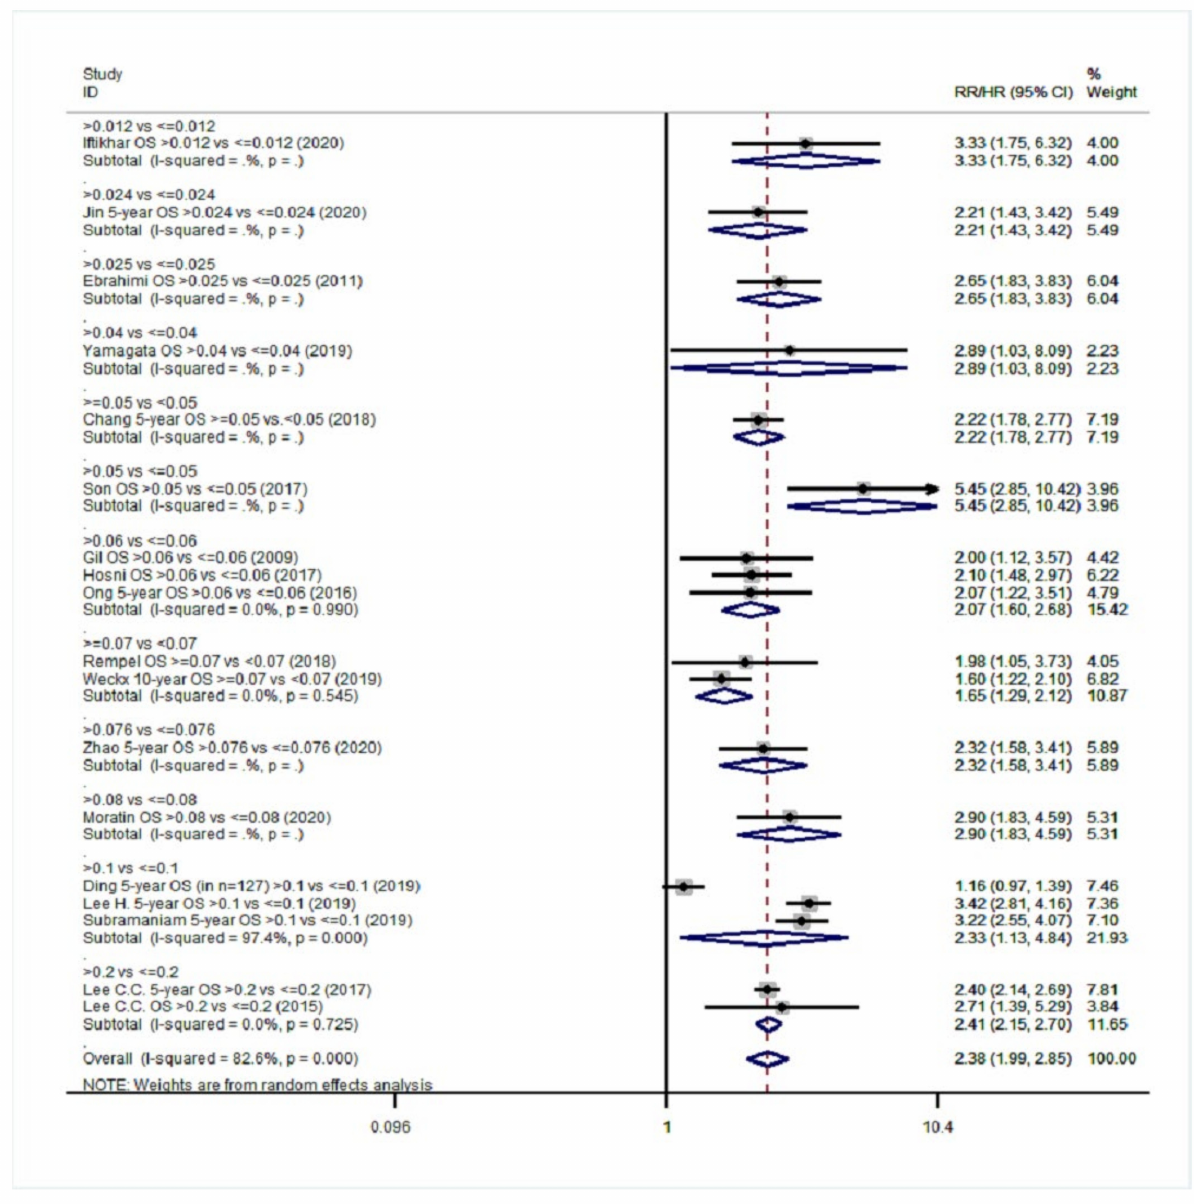
Figure 8. Forest plot showing associations between lymph node ratio (LNR) and overall survival (OS) in group NO. Apart from the overall analysis, the subanalyses by LNR cut-off values are